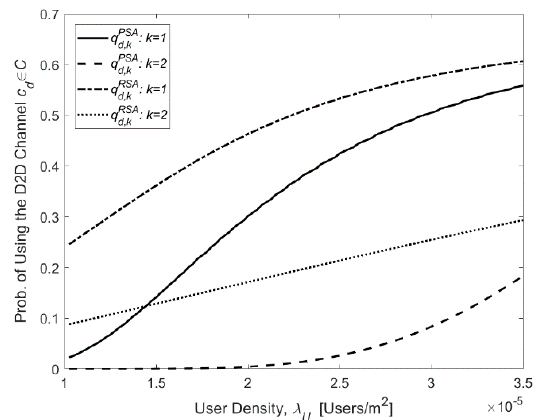
Figure 9. The 𝑞 𝑑,𝑘PSA and 𝑞 𝑑,𝑘RSA in the underlay in-band D2D mode vs. the intensity of users when both the RSA and PSA policies are used.